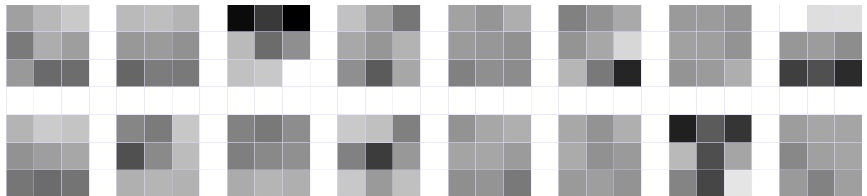
Figure 5. Vizualization of the kernel weights of the trained model. Black cells represent the minimum weight value ( − 1.262), and white cells represent the maximum weight value (1.010).